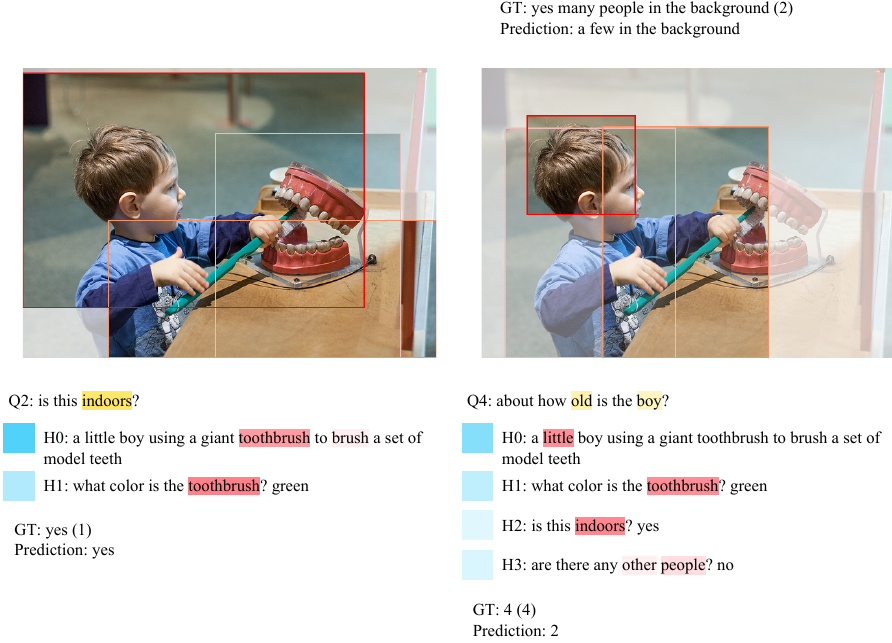
Figure A2. Visualization of the reasoning process for each module in